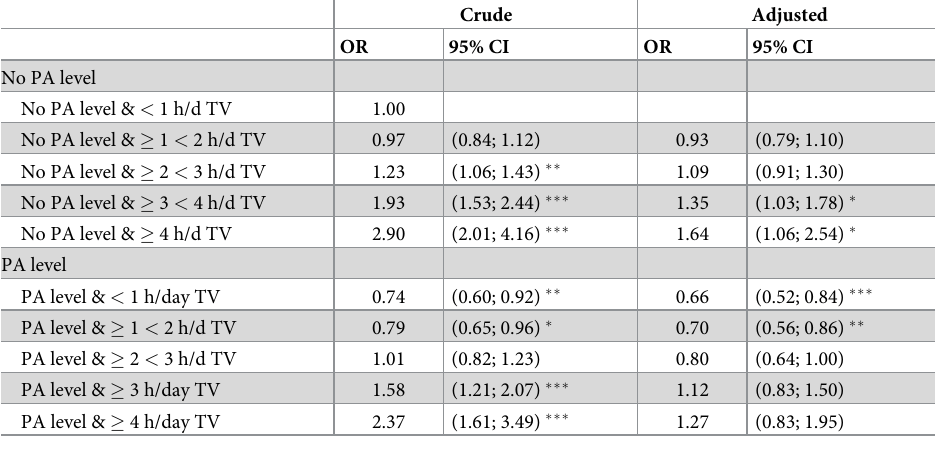
Table 4. Odds ratio to have Metabolic Syndrome considering combined effects of physical activity level and TV watching.